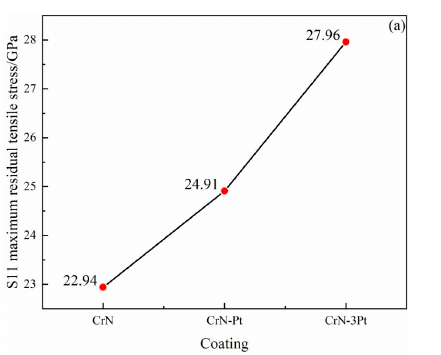
Coatings 2022 , 12 , x FOR PEER REVIEW Figure 15. Isotropic residual stress gradients on the surfaces of three coatings.